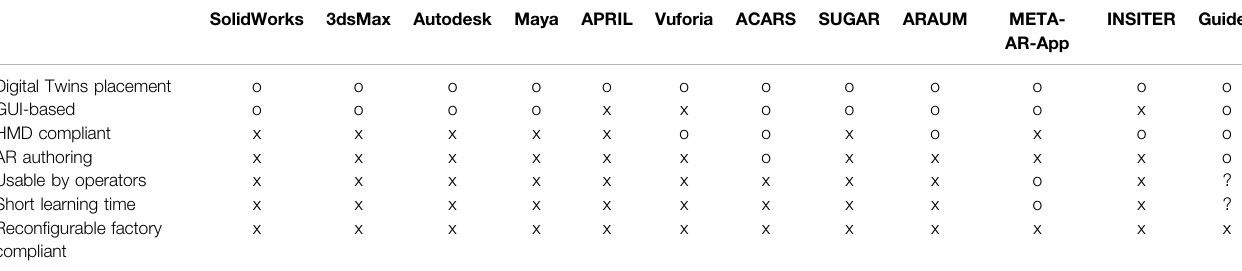
TABLE 1 | Summary of the main features of 3D authoring tools suited for AR matching of Digital